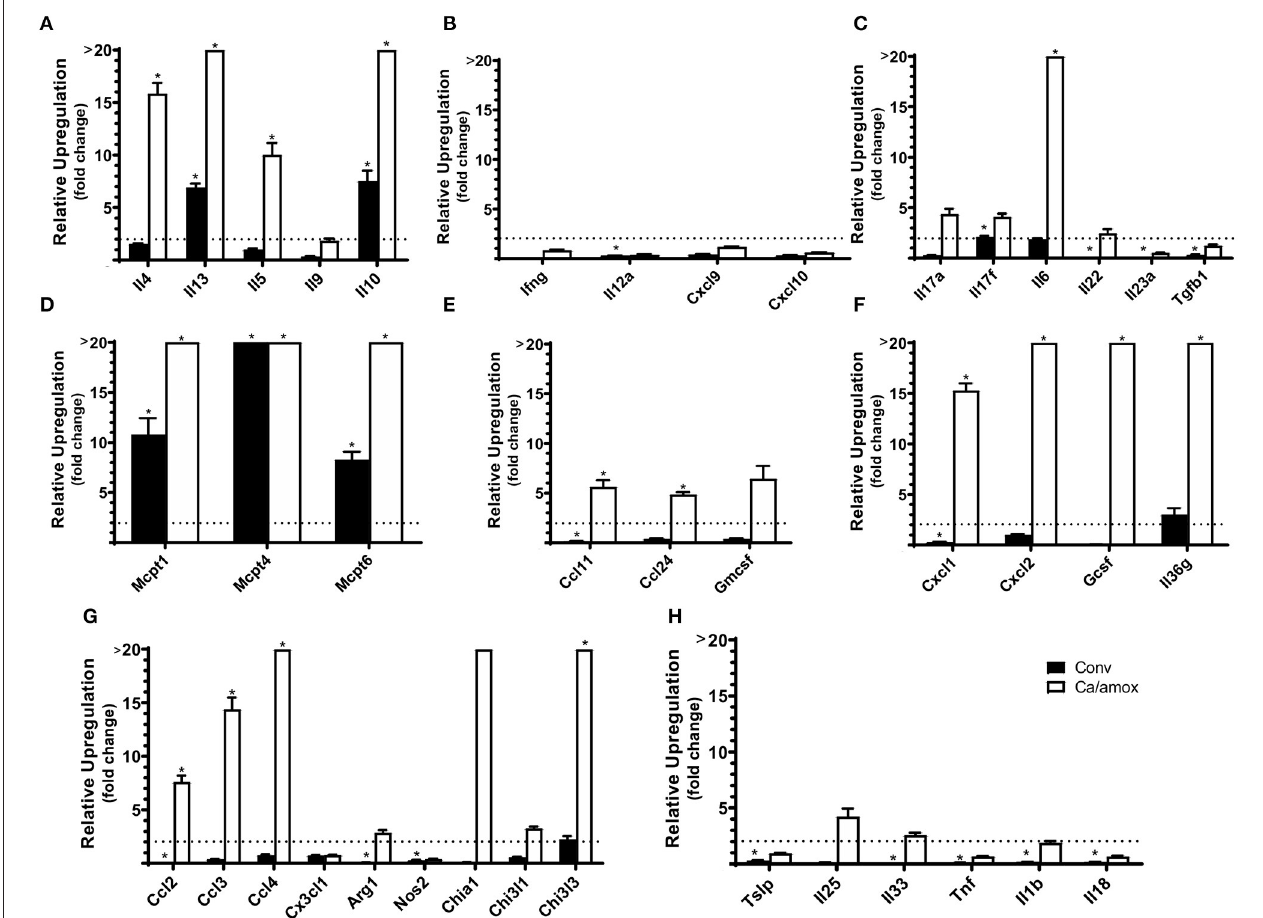
FIGURE 2 | Cytokine and chemokine gene induction in the ileum of Conv and Ca/amox Balb/cJ mice after food allergen (OVA) sensitization and challenge (D42) (A–H) . Data shown is relative expression compared to naive strain-matched mice. Mice were treated as outlined in Figure 1A . The dotted line indicates a two-fold upregulation from baseline expression levels. Gene expression was measured by qPCR. Statistical significance (* P < 0.05) signifies significant upregulation in the treated compared to the naïve group for each gene (treated, n = 9-10, naïve, n = 5). Data are plotted as the mean ± SEM. Detailed description of analyses and statistical tests used can be found in the Materials and Methods. Definitions of gene abbreviations can be found in Table 1 .